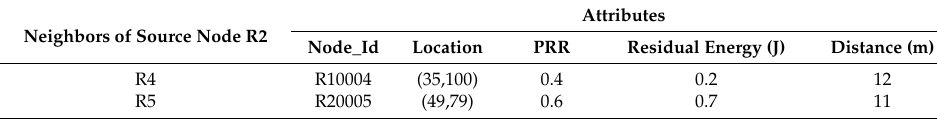
Table 6. Description of neighbors of R2 along with its features.